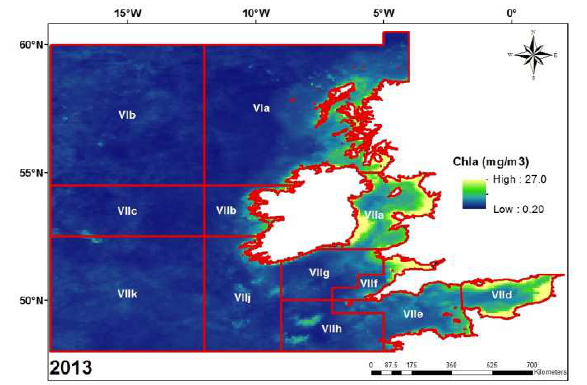
Figure 3. Map of chlorophyll-a concentration for 2013